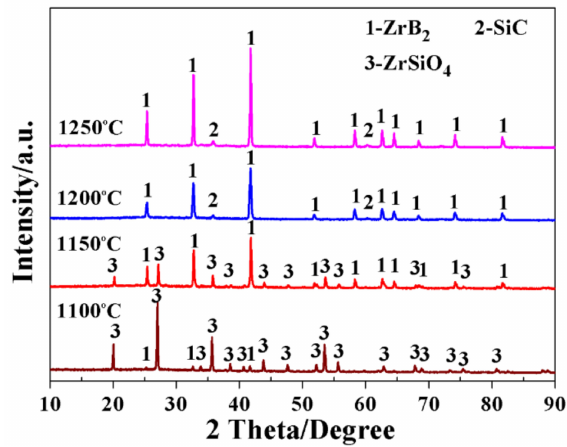
Figure 3. XRD patterns of the samples resulting from the MSM-BCTR method at 1100–1200 ◦ C, with a soaking time of 20